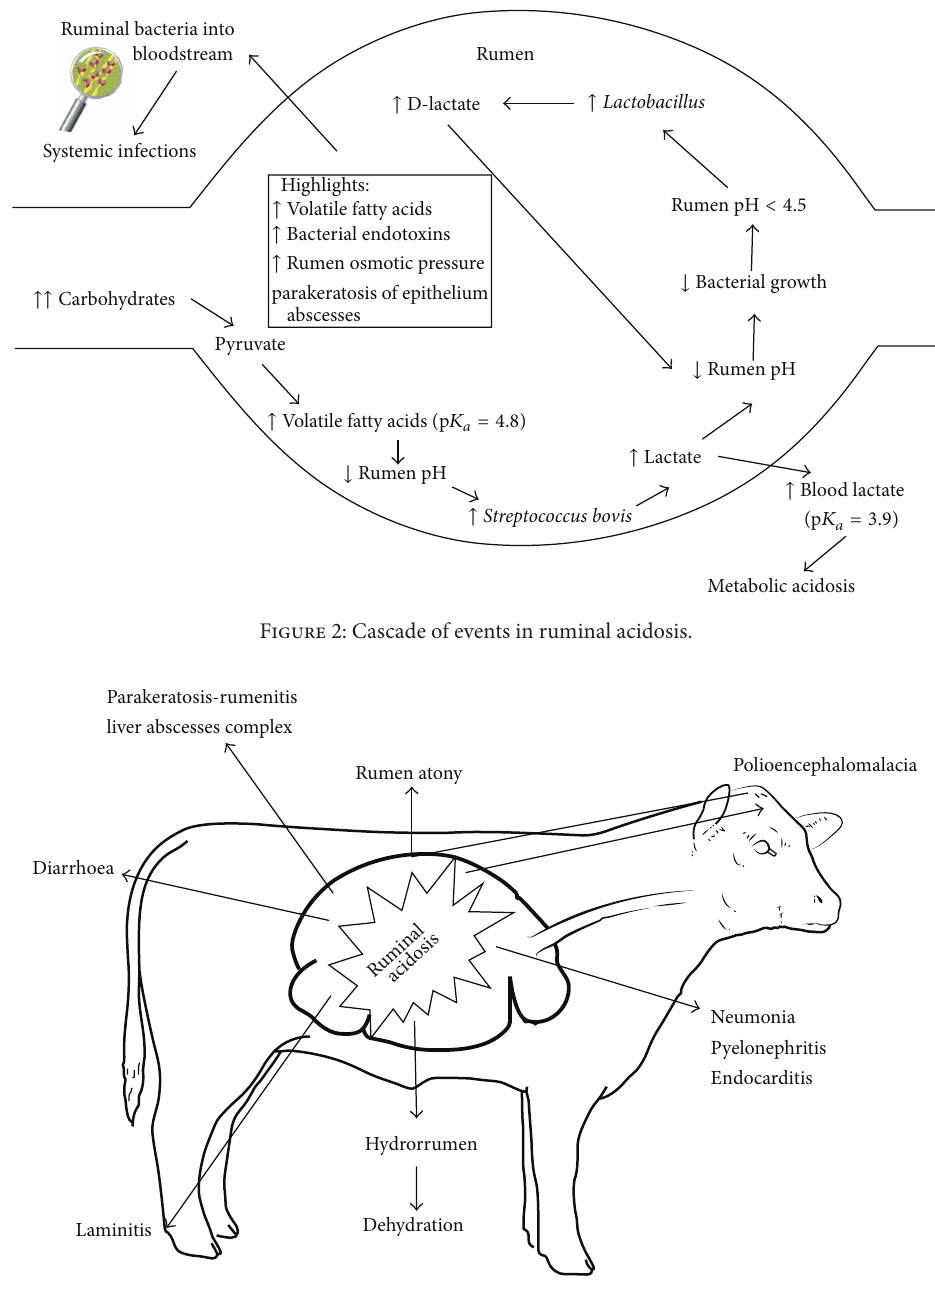
Figure 3: Clinical picture of the